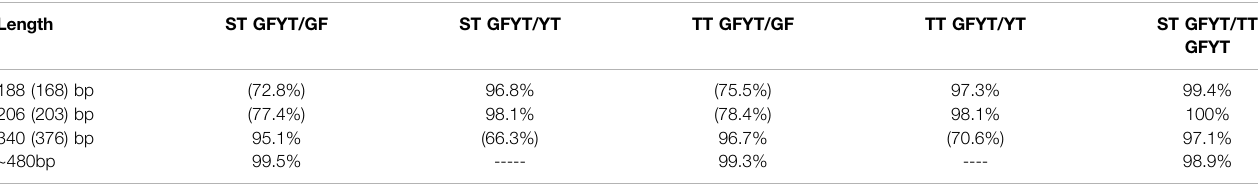
TABLE 5 | Similarities of 5S rDNA sequences between hybrids and their